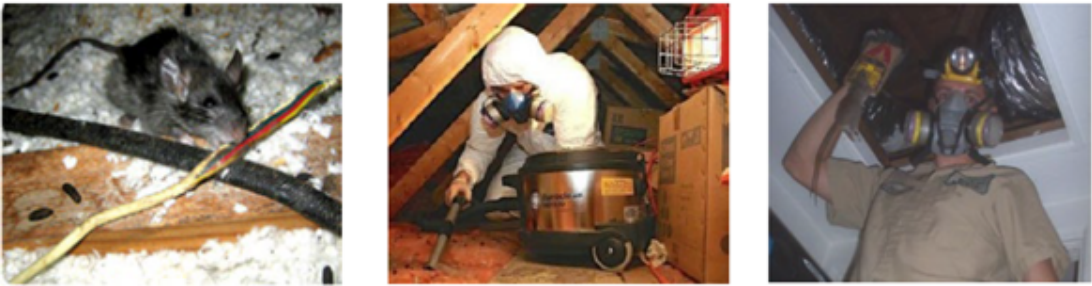
Figure 1. Manual inspection and hazard of pests on false ceiling (source: Google